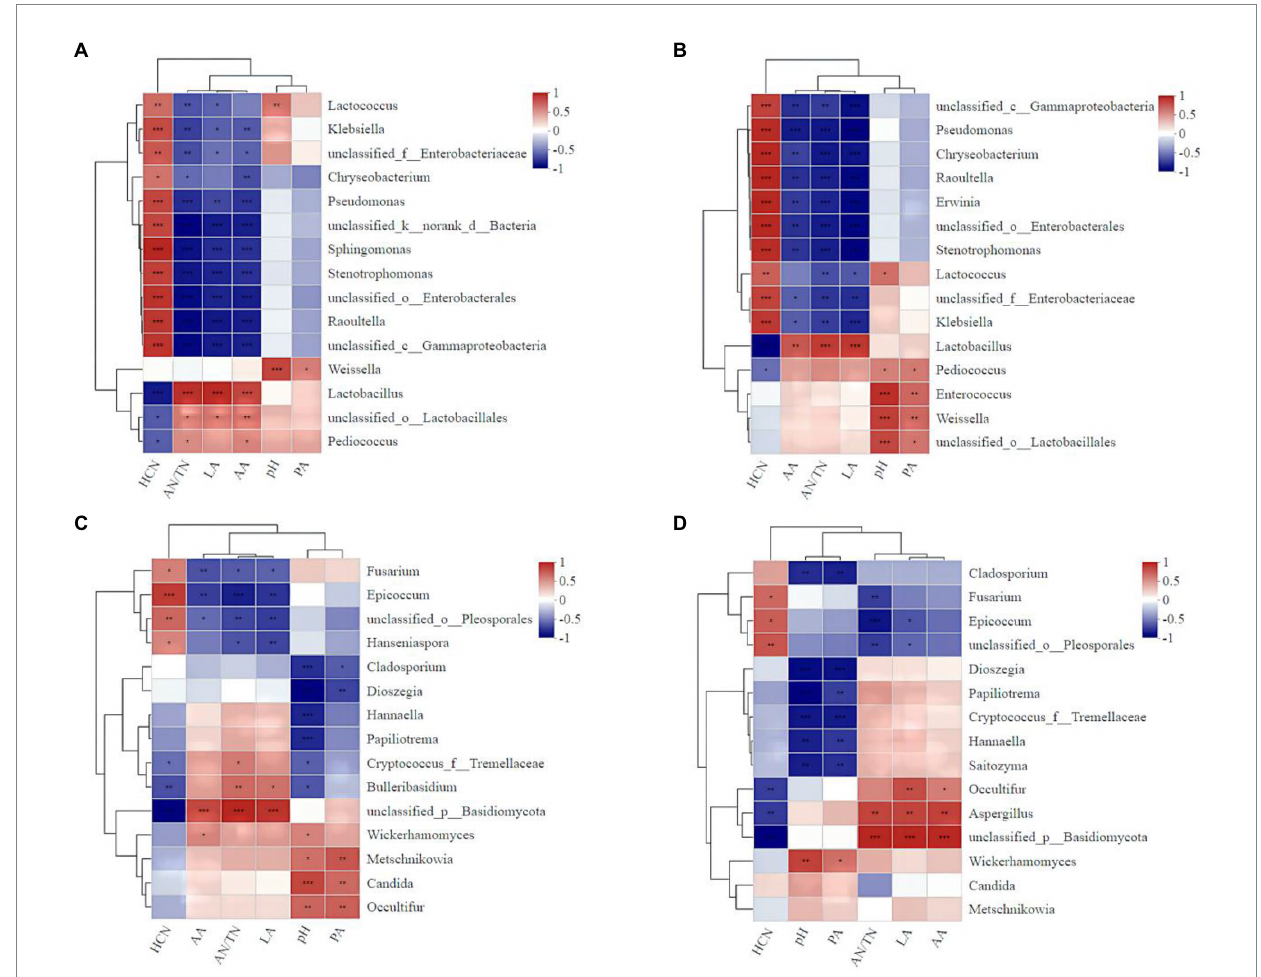
FIGURE 8 Heat map of the correlations between bacterial (fungal) species and the fermentation characteristics and the HCN content of ratooning sorghum silage. Fermentation characteristics and HCN content are displayed horizontally and the top 15 bacterial species were displayed vertically. The corresponding value of the middle heat map is the Spearman correlation coefficient r , the legend on the right is the color distinction of different r values; r < 0 indicates a negative correlation (blue), r > 0 indicates a negative correlation (red), and ‘*’, ‘**’, and ‘***’ represent p < 0.05, p < 0.01, and p < 0.001, respectively. (A) , bacterial of control; (B) , bacterial with A. niger addition; (C) , fungal of control; (D) , fungal with A. niger